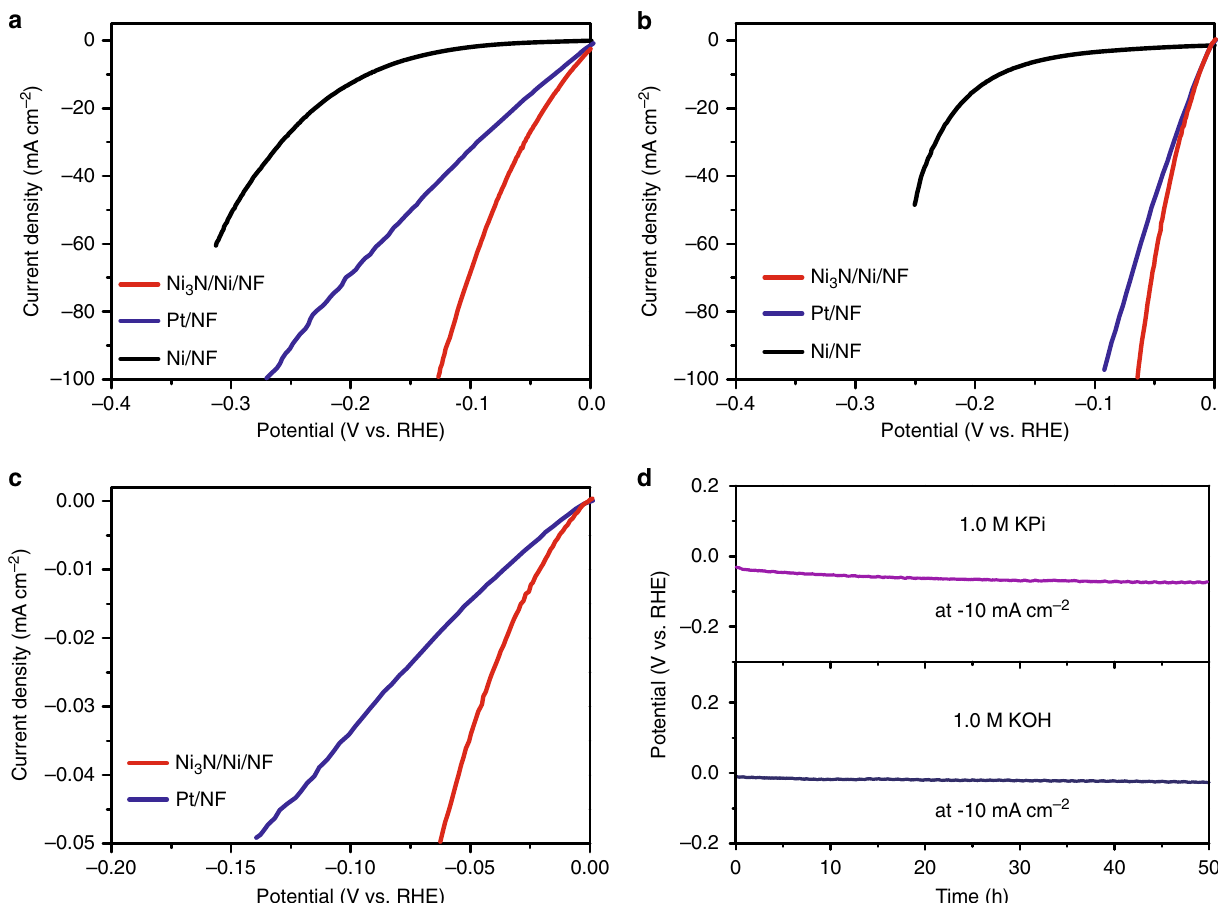
Fig. 2 The electrocatalytic HER performance in neutral and alkaline solutions. a , b Linear sweep voltammetry (LSV) curves of Ni 3 N/Ni/NF, Ni/NF, and optimized Pt/NF (Pt/C: 2.5 mg cm − 2 ) for HER in 1.0 M potassium phosphate (KPi) buffer ( a ) and 1.0 M KOH ( b ) with the current density normalized by the geometric electrode area. c LSV curves of Ni 3 N/Ni/NF and Pt/NF for HER in 1.0 M KOH with the current density normalized by their respective BET surface areas. All LSV curves are iR-corrected. d Chronopotentiometry curves of Ni 3 N/Ni/NF collected at − 10 mA cm − 2 normalized by the geometric electrode area in 1.0 M KPi (top) and 1.0 M KOH (bottom) without iR